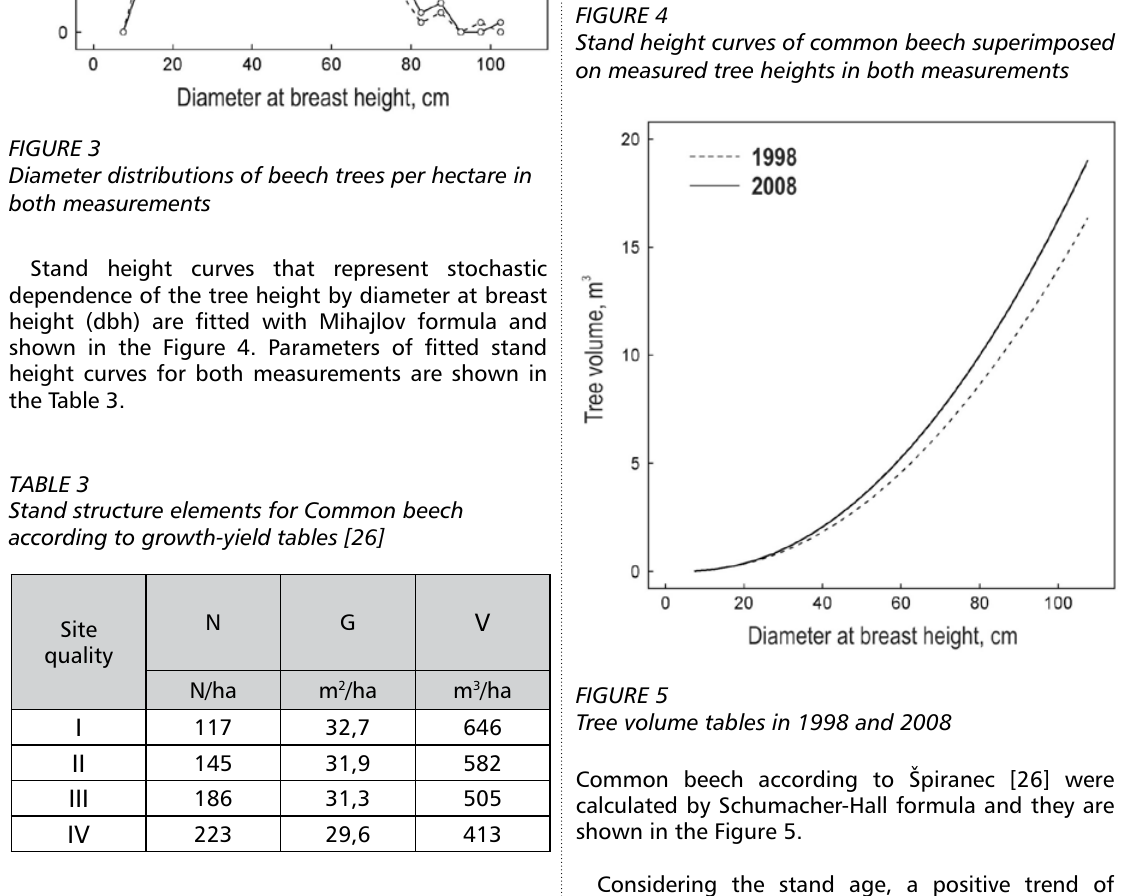
FIguRe 4 Stand height curves of common beech superimposed on measured tree heights in both